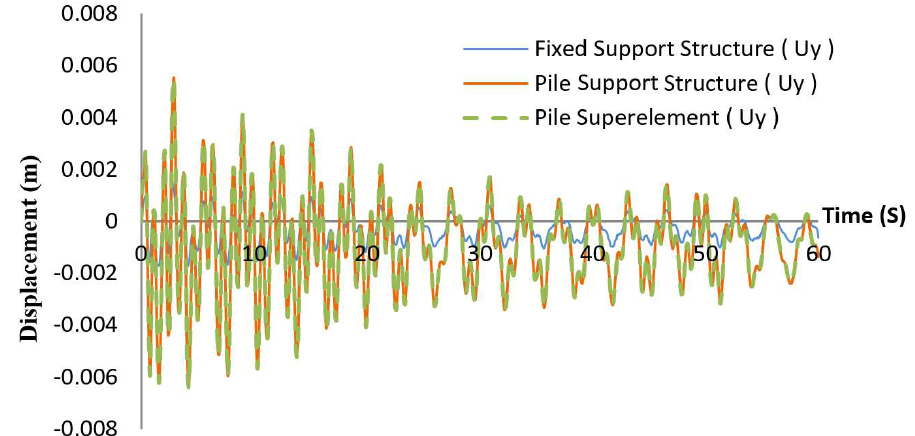
Figure 17. A comparison of the displacement on the fixed support structure, pile support structure and pile superelement models in the y-direction.